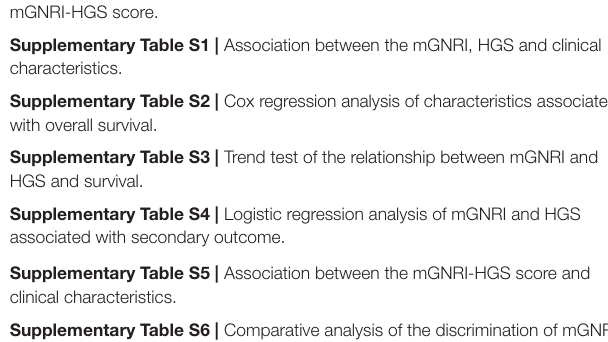
Supplementary Figure S6 | Stratified survival analysis of mGNRI, HGS, and mGNRI-HGS score based on sex. (A) , male; (B) , female. Supplementary Figure S7 | Stratified survival analysis of mGNRI, HGS, and mGNRI-HGS score based on tumor types. (A) , mGNRI; (B) , HGS; (C) , mGNRI-HGS score.